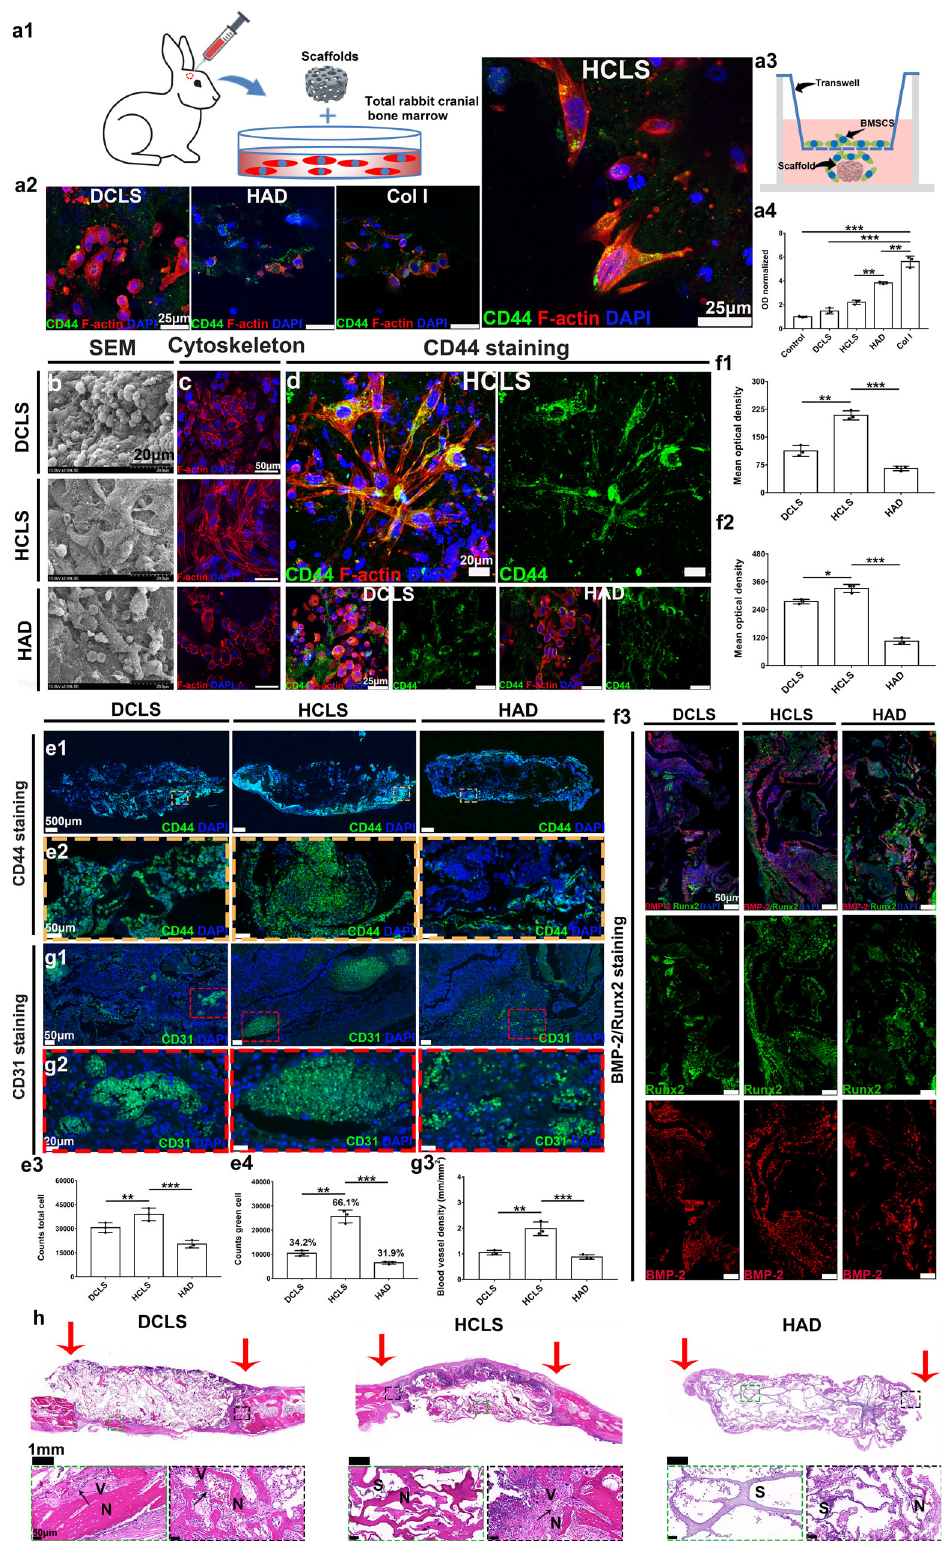
related gene expression in ECM structure and organization, integrin binding, epidermal cell differentiation, ossi fi cation, peptide binding, vasculogenesis, and labyrinthine layer blood vessel